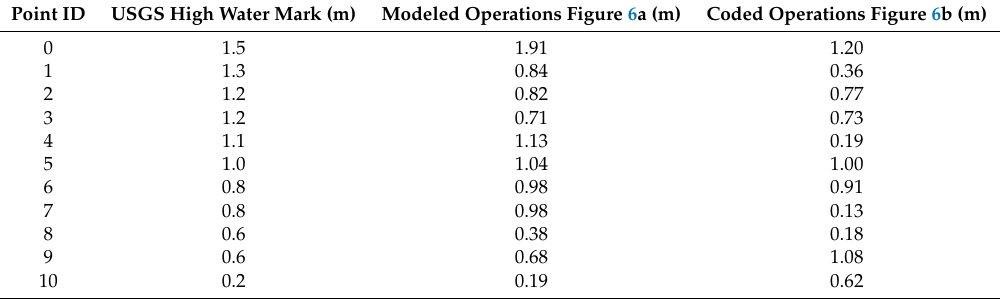
Figure 6. ( a ) Modeled hindcast of observed USGS operations data for Harvey floodplain extent; ( b ) Coded operations hindcast of Harvey floodplain extent. Table 1. Flood depth comparison of USGS observed high water marks from Figure 6a,b.